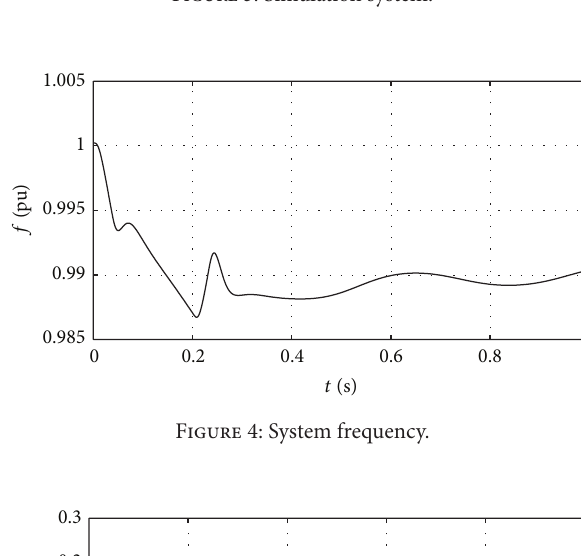
Figure 3: Simulation system.